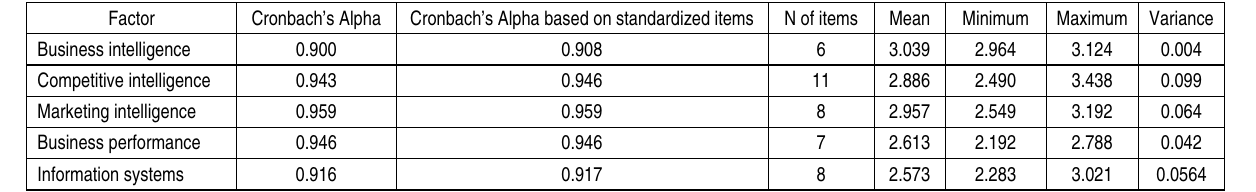
Table 5. Results of factor reliability